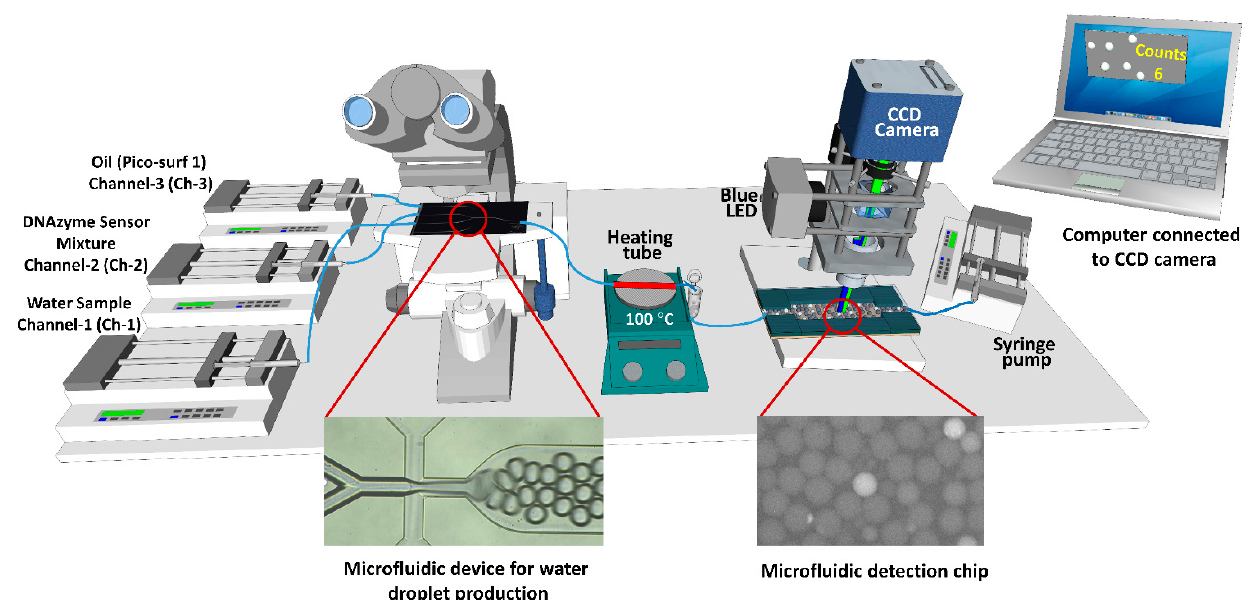
Figure 1. Scheme of the microfluidic set-up for the isolation and detection of E. coli .